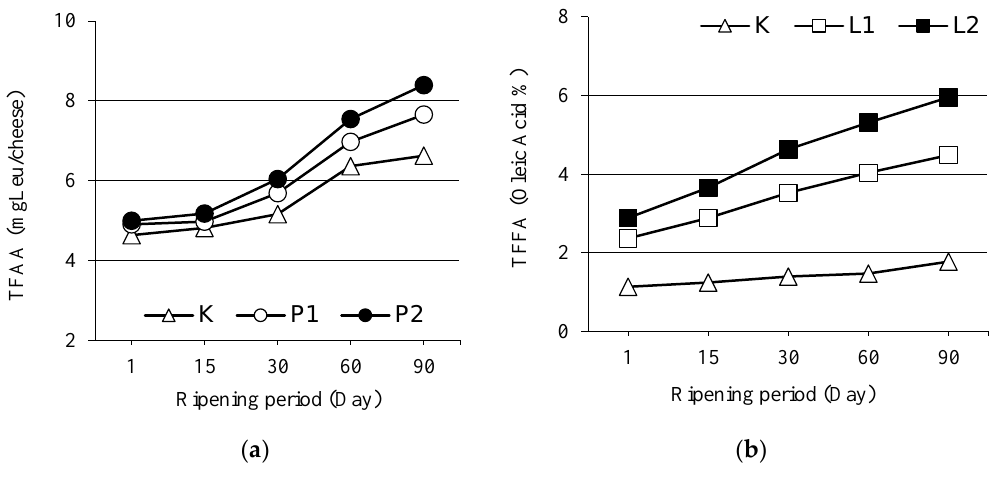
( a ) ( b ) Figure 2. ( a ) Total free amino acids (TFAA); and ( b ) Total free fatty acids (TFFA) contents of White cheeses during ripening.